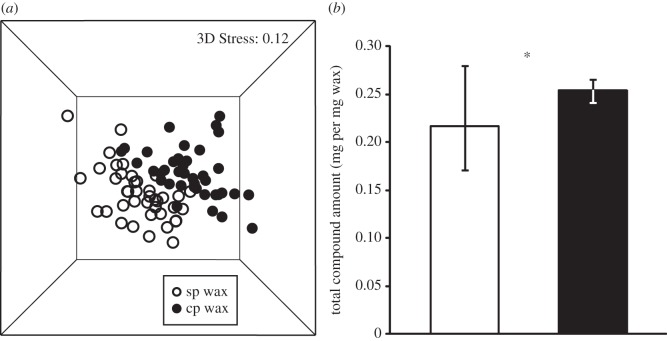
Differences in (a) wax scent profiles and (b) total amounts of wax compounds from social-phase (sp) and competition-phase (cp) colonies. (a) Based on relative amounts of compounds, wax scent profiles differed between sp and cp colonies (NMDS, Bray–Curtis similarity measure; 3D Stress 0.12; sp, open circles; cp, filled circles). (b) Cp wax contained significantly higher absolute amounts of compounds than sp wax (median, 25th and 75th percentile; sp, white bar; cp, black bar; U-test: U=1413, n=40, *p=0.047).